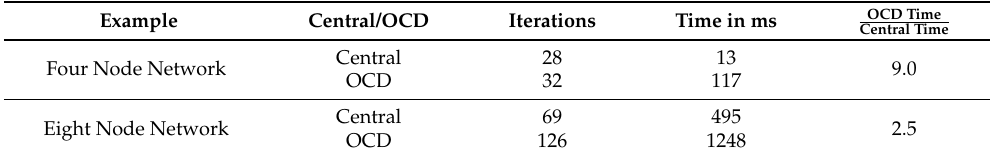
Table 2. Computation time and iteration counts for the considered examples. Example Central/OCD